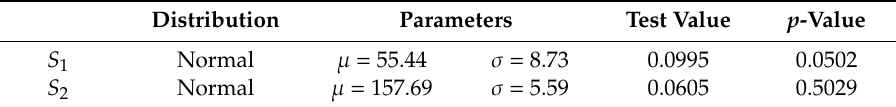
Table 10. Fitting distribution of 𝑆 (cid:2869) ,𝑆 (cid:2870) and goodness of fit test.